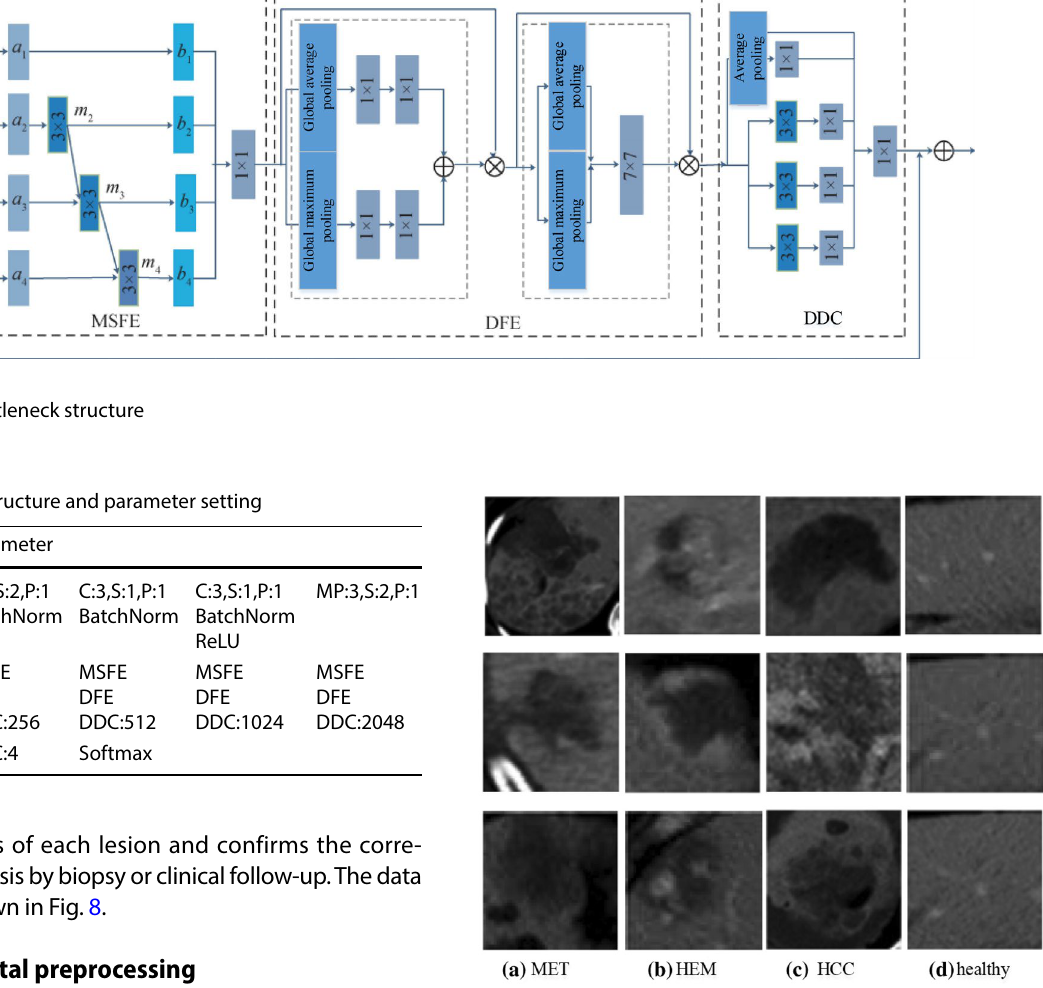
Fig. 8 Typical samples of liver dataset